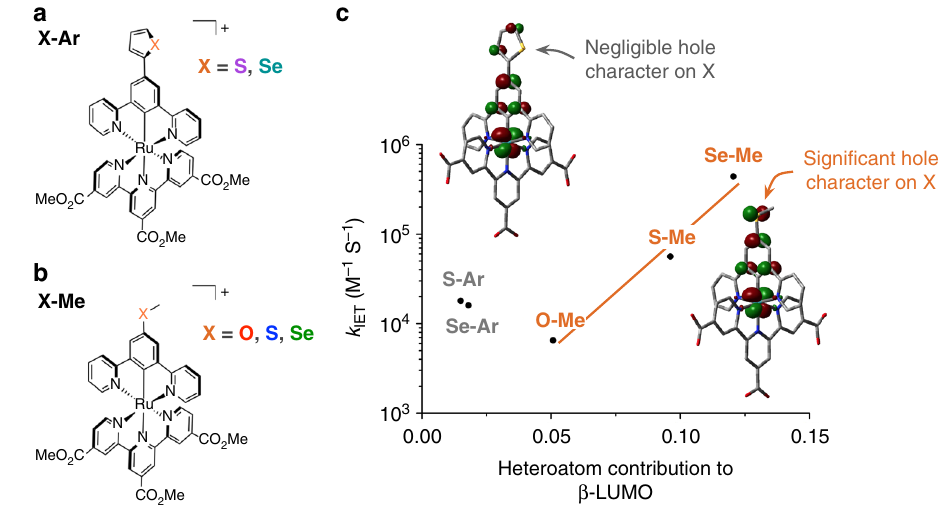
Fig. 2 Ruthenium complexes to control β -LUMO delocalization. a , b Chemical structures of the X-Ar a and X-Me b compounds under investigation. The methyl ester groups are converted to acids to enable binding to titania. c Plot of the second-order IET rate constant ( k IET ) for the indicated compounds versus the heteroatom contribution to the β -LUMO ( c A,X ), overlaid with representative visualizations of the β -LUMO of X-Ar (left) and X-Me (right) plotted at an iso-value of 0.05 Table 1 Optical and redox properties of ruthenium complexes in solution and immobilized on mesoporous metal oxide (MO X ) thin fi